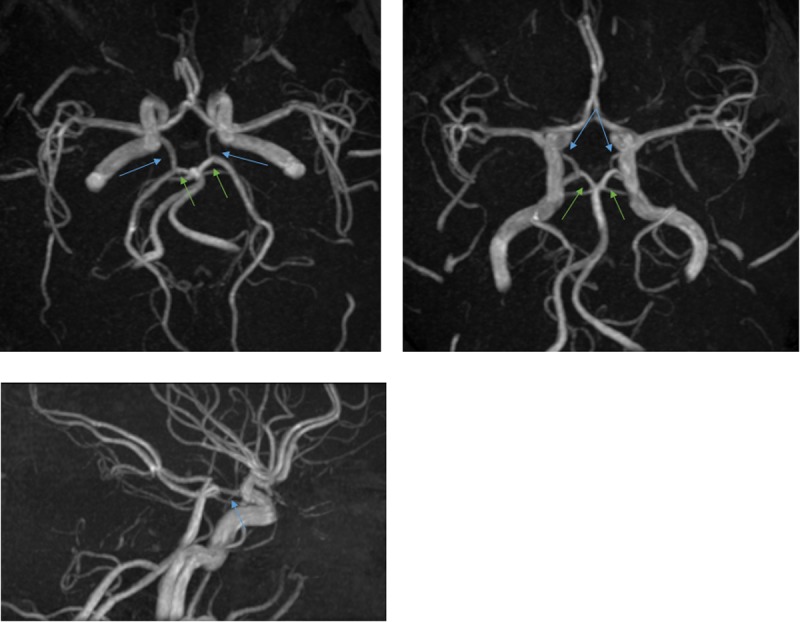
Complete posterior part of circle Willis.Blue arrows point to PCoA. Green arrows point to P1 segments of PCA.